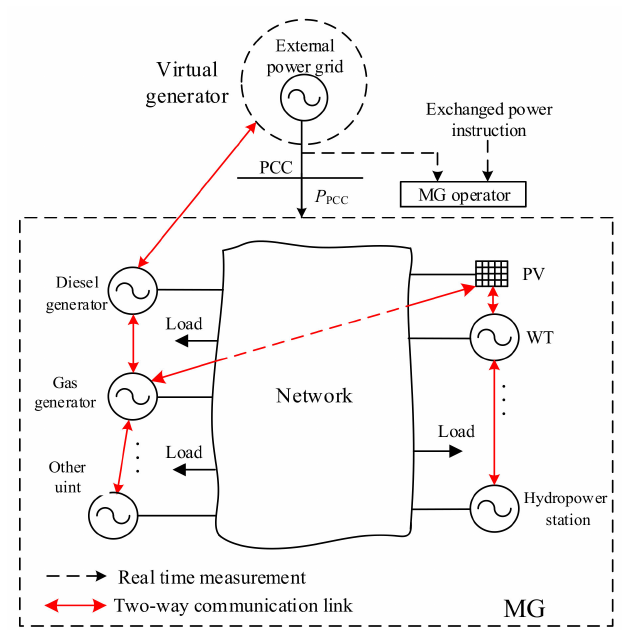
Figure 1. General structure of a microgrid (MG) with a virtual